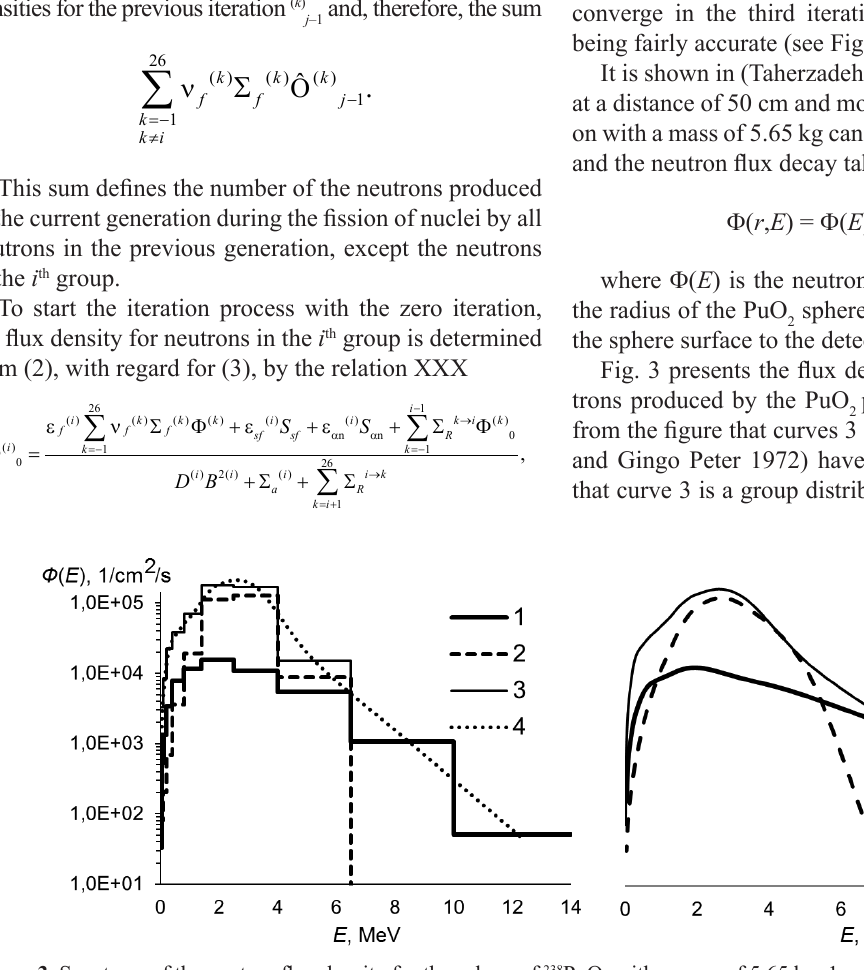
Figure 3. Spectrum of the neutron flux density for the sphere of 238 PuO and 28-group; 2 – ( α,n)-reactions; 3, 4 – total